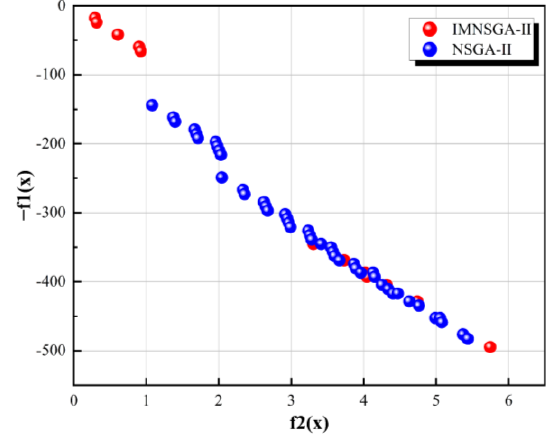
Figure 7. Comparison of Pareto optimal fronts between IMNSGA-II and NSGA-II.